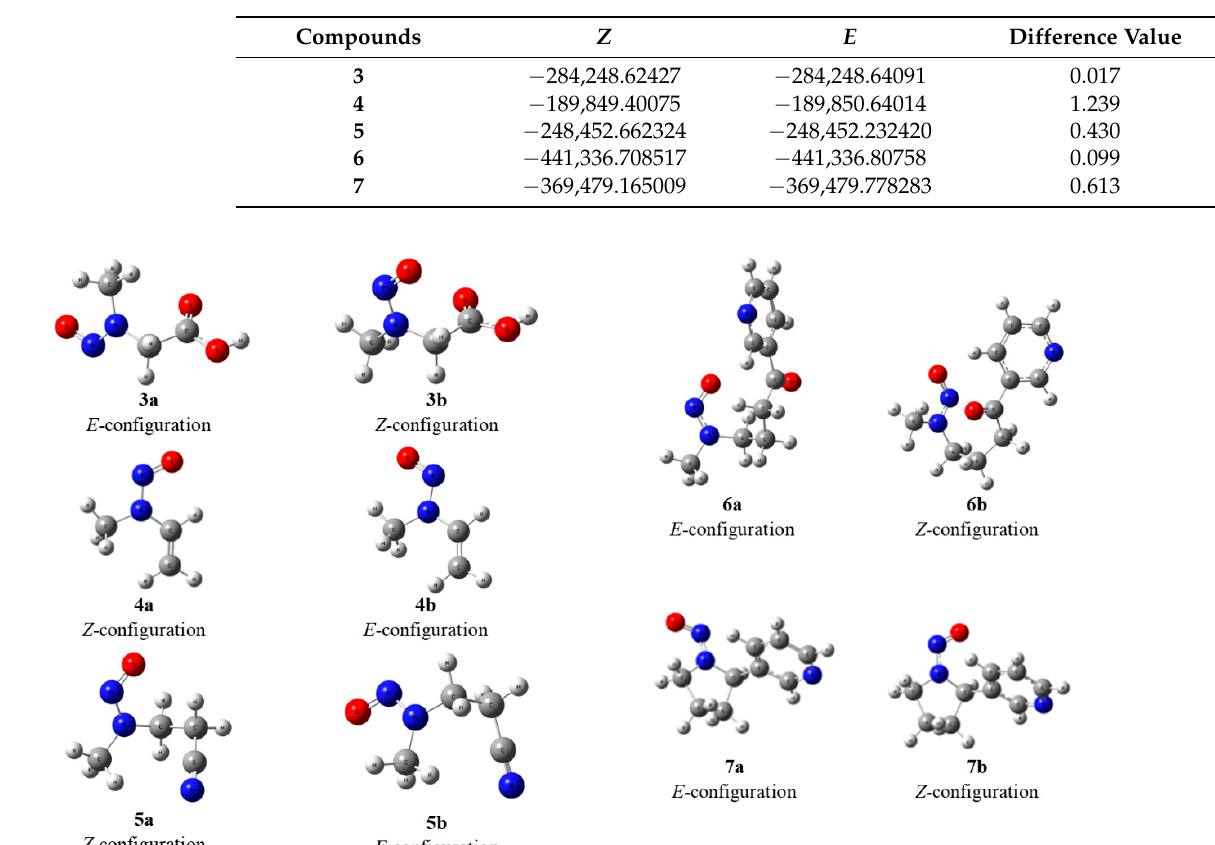
Figure 6. Optimized conformers derived from DFT calculations for asymmetrical N-nitrosamines 3 – 7 . Table 6. The Gibbs free energy values (G, Kcal/mol) of Z / E isomers for compounds 3 – 7 at